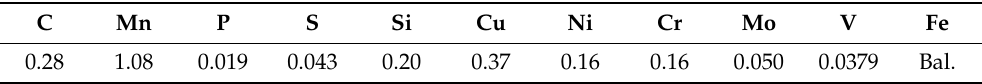
Table 7. Elemental composition of grade 75 carbon steel rebar